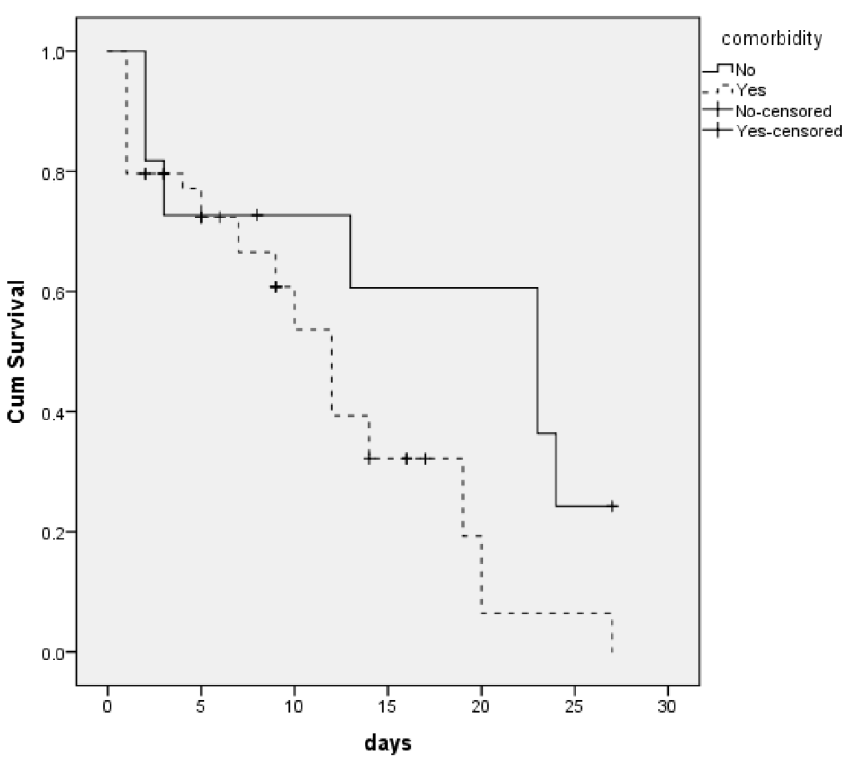
Figure 2. Survival curve for patients according to their comorbidities.